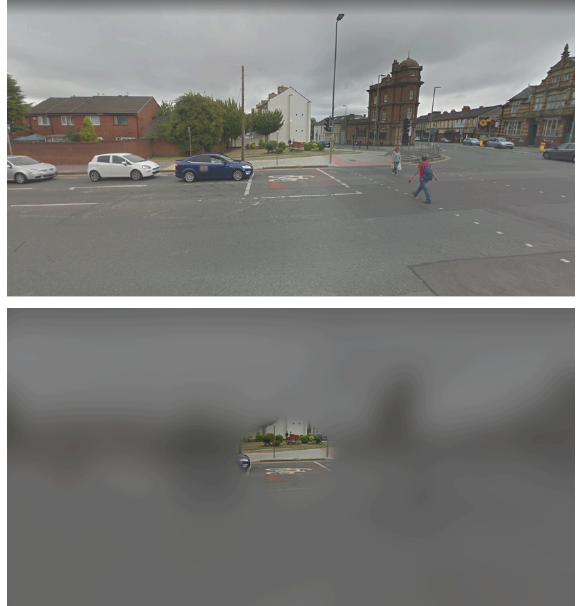
Figure 2. A simulated view for the healthy vs. tunnel vision might appear. The top picture shows the healthy vision; the bottom image shows how a person with tunnel vision might see the same scene.